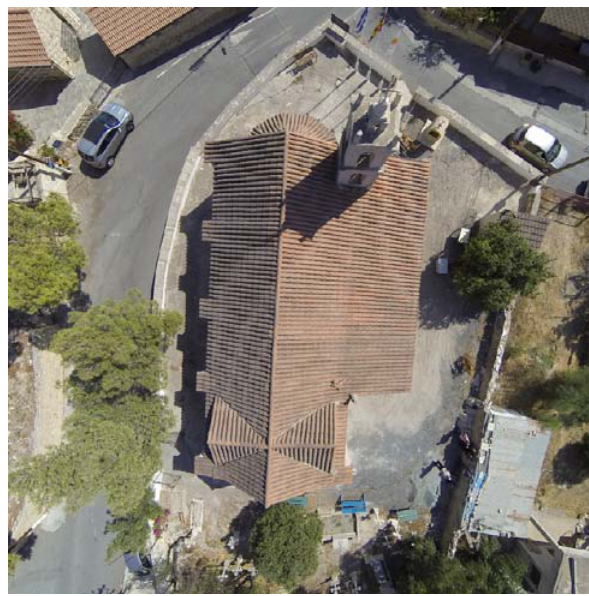
Figure 2. Foinikaria Church, aerial view